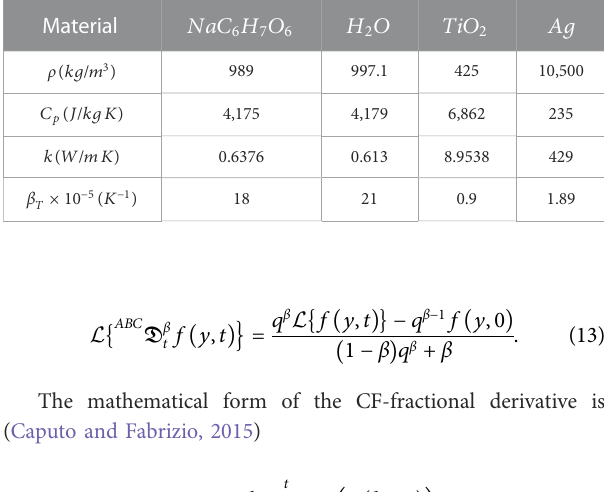
TABLE 2 Thermal features of nanoparticles and regular fl uids. Material